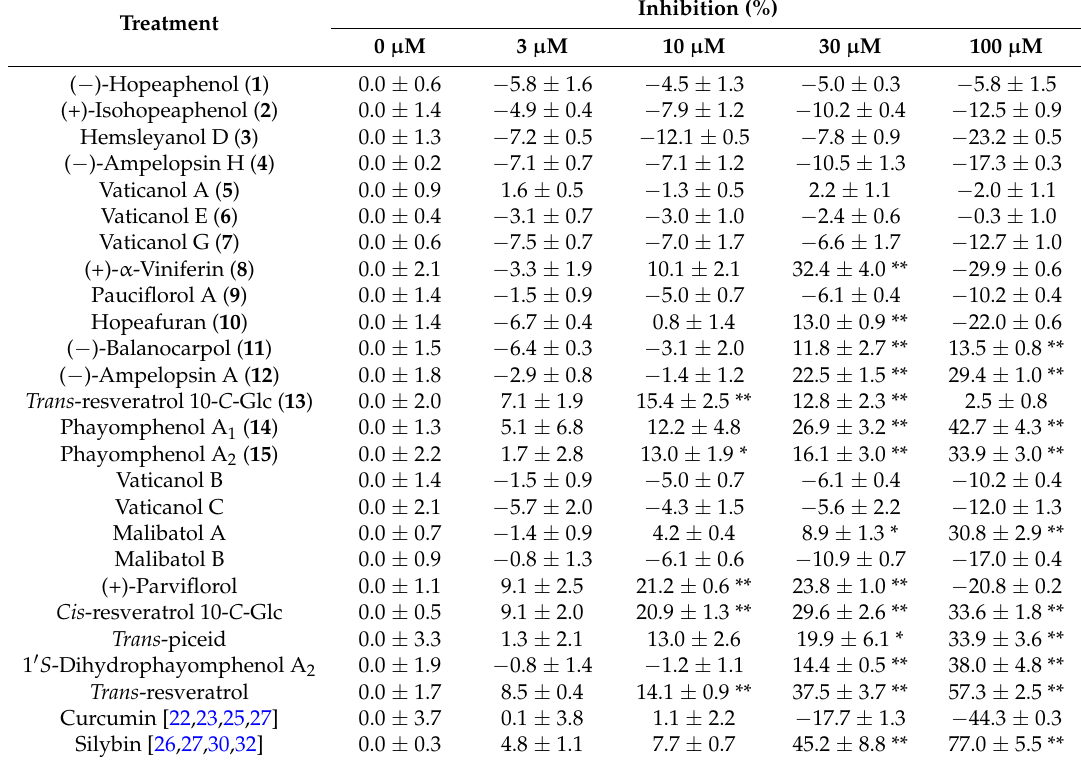
Table 6. Inhibitory effects of constituents from the bark of Shorea roxburghii on D -GalN-induced cytotoxicity in mouse primary